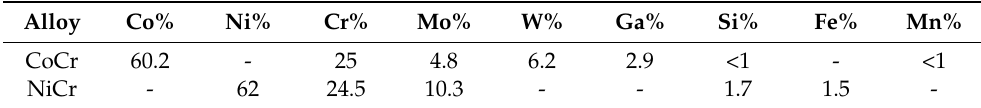
Table 1. Composition of NiCr and CoCr alloys